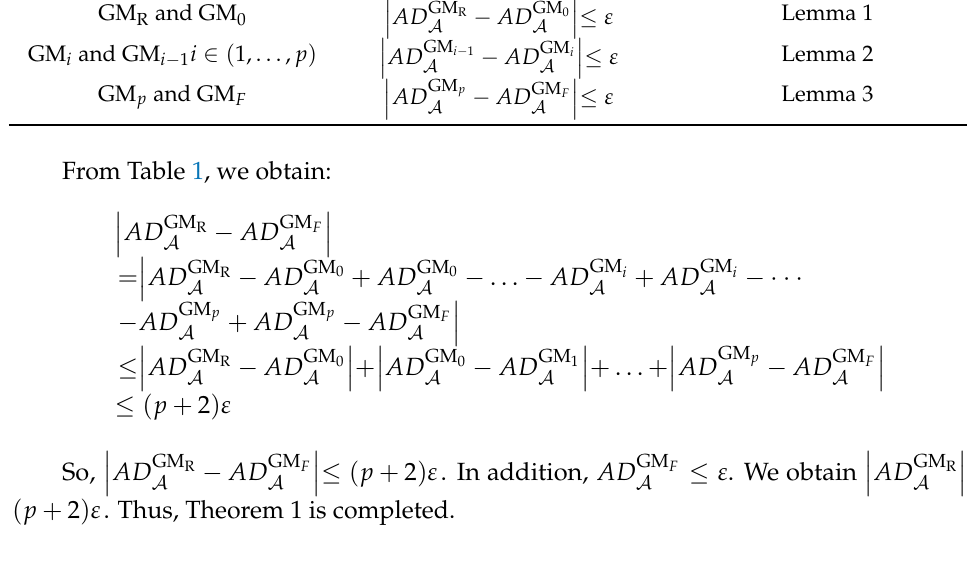
The Differences of Adversary’ Advantages (cid:12) (cid:12) GM R (cid:12) (cid:12) − AD GM 0 ≤ ε Lemma (cid:12) AD (cid:12) A A